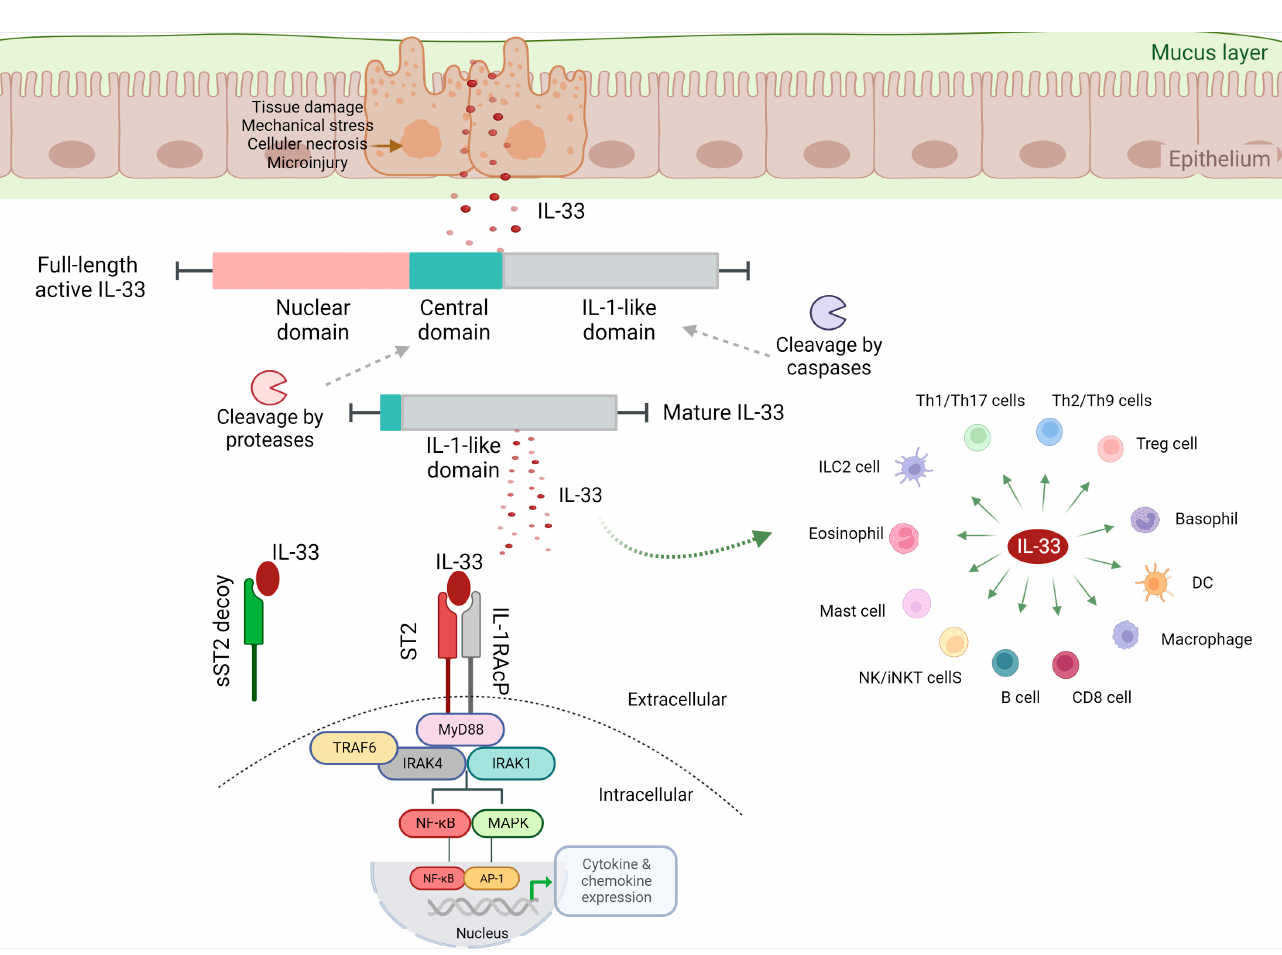
Figure 2. Activation of IL-33/ST2 signaling. Full-length IL-33 is composed of an N-terminal nuclear domain and a C-terminal IL-1-like cytokine domain, divided by a central domain. IL-33 signals through a great variety of immune cells promoting their function. Binding of IL-33 to sST2 decoy receptor prevents the ST2/IL-33 signaling, whereas binding of IL-33 to ST2 results in the activation of the transcription factor NF- κ B and the MAP kinases, leading to related-gene transcription. This figure was created with BioRender (https://biorender.com (accessed on 29 November 2022)). IL-33, interleukin-33; ST2, suppression of tumorigenicity 2; sST2, soluble ST2; IL-1RAcP, IL-1 receptor accessory protein; MyD88, myeloid differentiation primary response 88; TRAF6, tumor necrosis factor receptor-associated factor 6; IRAK 1, interleukin receptor-associated kinase; NF- κ B, nuclear factor κ B; MAPK, mitogen-activated protein kinases; AP-1, activator protein 1; Th1 cells, T helper 1 cells; Treg cells, T regulatory cells; DC cells, dendritic cells; CD8 cells, cytotoxic T cells; NK cells, natural killer cells; iNKT cells, invariant natural killer T cells; ILC2 cells, group 2 innate lymphoid